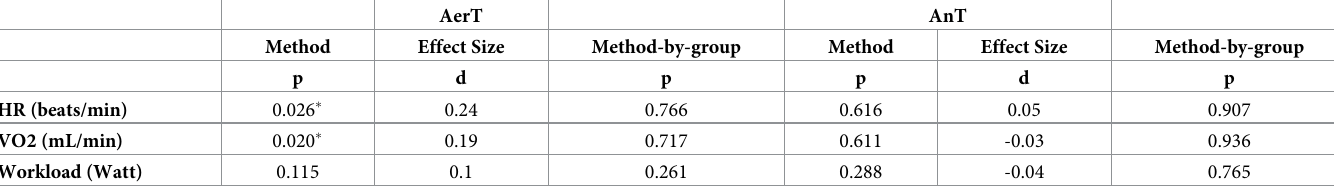
Table 3. Main effects of methods (RQA vs GE) with Effect Size (Cohen’s d) and method-by-group (A, B and C) interaction effects (RM ANOVA).